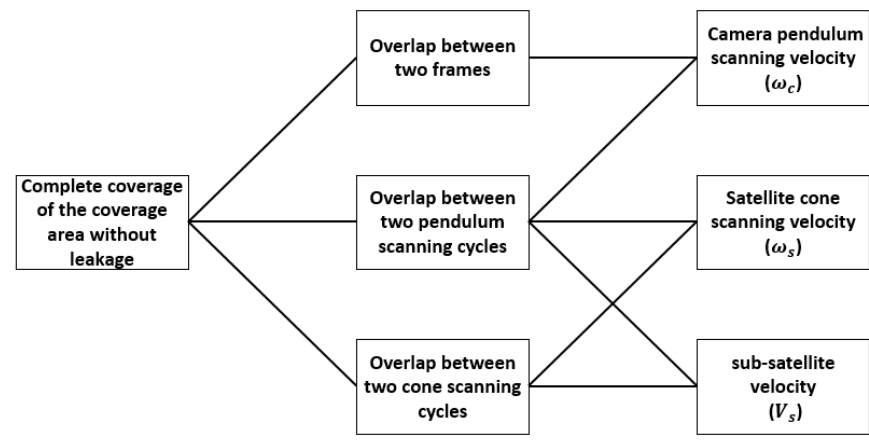
Figure 7. Key parameter relationship diagram.